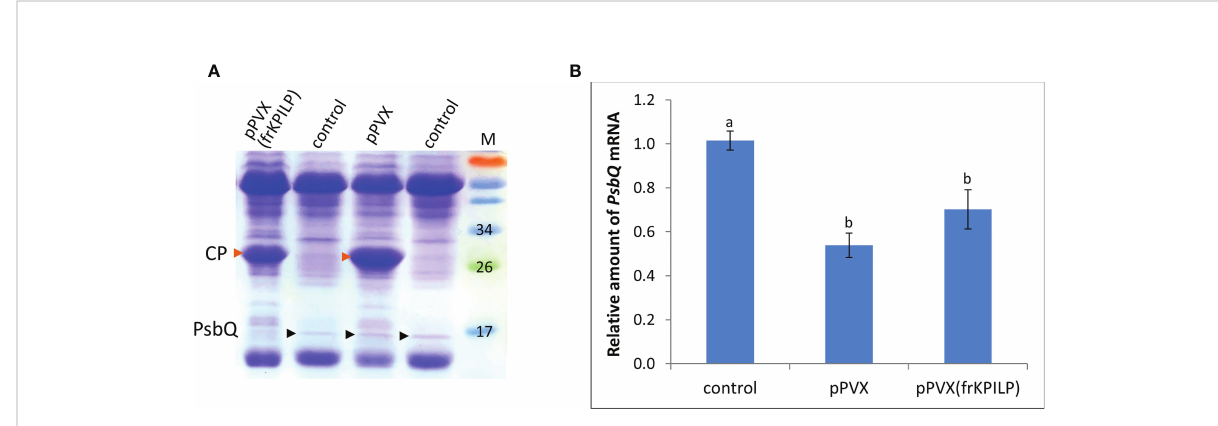
FIGURE 2 KPILP downregulation in PVX-infected N. benthamiana plants leads to decreased accumulation of PsbQ. (A) Analysis of total soluble protein from leaves with systemic infection induced by pPVX or pPVX(frKPILP) and control intact plants in polyacrylamide gel followed by Coomassie staining. Bands corresponding to PVX CP are indicated with red arrowheads, bands corresponding to PsbQ 16kDa protein are indicated with black arrowheads. M, protein weight markers. (B) Relative amount of PsbQ mRNA in the intact and PVX-infected plants as determined by qPCR. Mean values and standard errors are presented. The level of mRNA accumulation for control was taken as 1. Difference between control and samples from PVX-infected plants is signi fi cant at p<0.05 (ANOVA, Tukey ’ s HSD test). Bars without shared letters indicate signi fi cant differences. The difference between pPVX and pPVX(frKPILP) is signi fi cant at